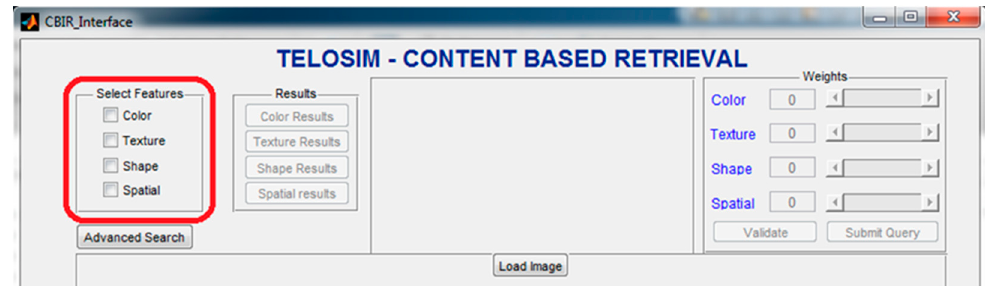
Figure 8. Content Based Image Retrieval (CBIR) Application.